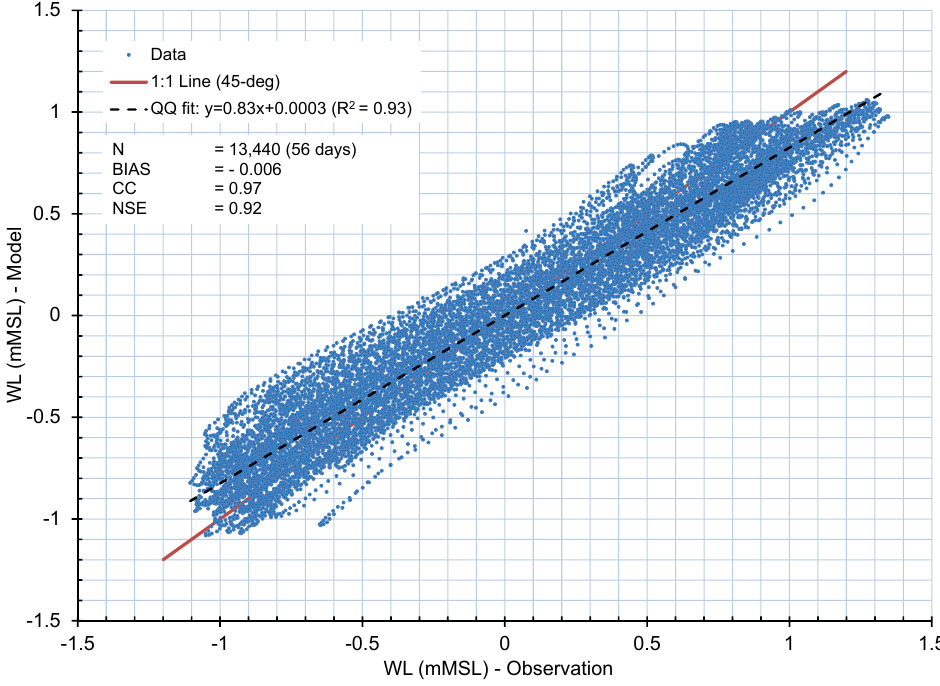
Figure 7. Scatter plot of modeled and measured water level at the Ship John Shoal NOAA